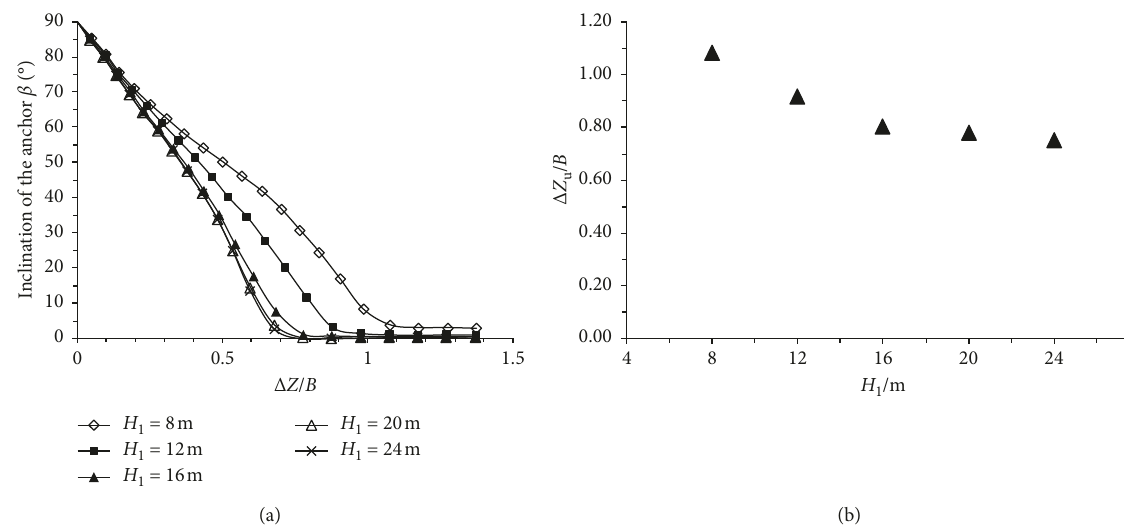
Figure 9: Influence of top soil layer thickness on the plate anchors at position P loss; (b) the embedment loss for various H 1 values.